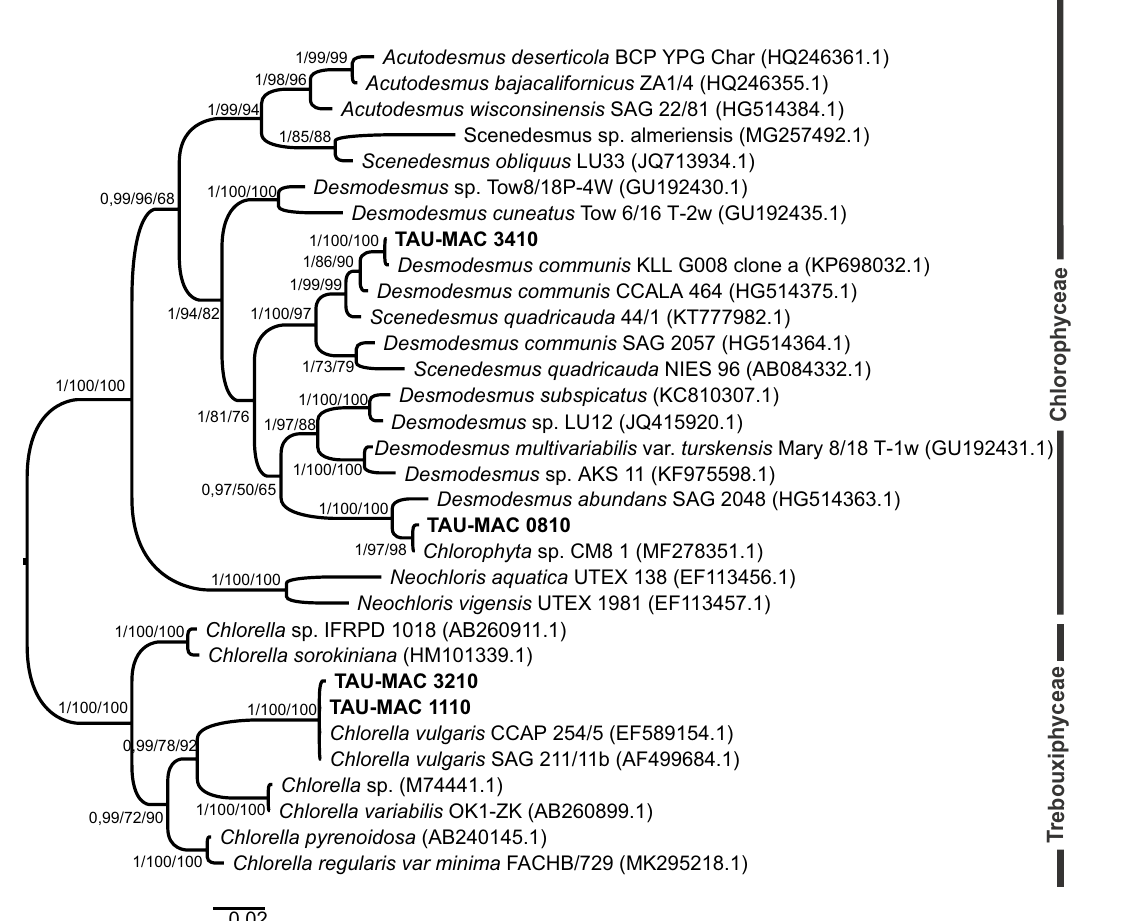
Fig. 5 Bayesian inference (BI) phylogenetic tree of relationships of rbcL cpDNA (c. 1100 bp) of green algae including the classes Chlorophyceae and Trebouxiophyceae. Support values are indicated as posterior probability for BI and bootstrap support for maximum likelihood (ML) and maximum parsimony (MP) analysis (BI/ML/MP). The numbers in parentheses are GenBank accession